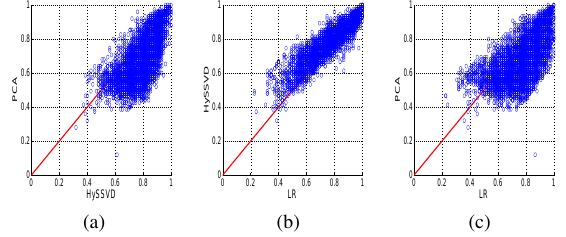
Figure 9: Scatter plot of Kendall Tau values for class Wheat